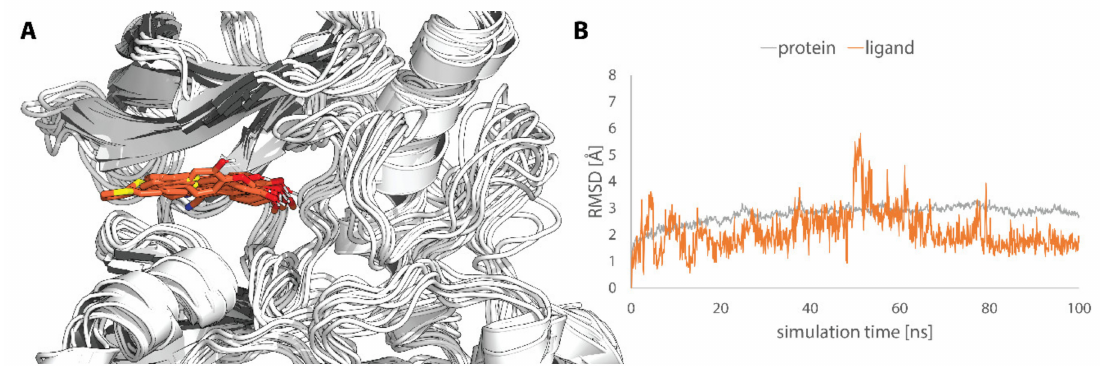
Figure 7. Results of a 100 ns MD simulation of VEGFR-2 in complex with compound 1c in the proposed binding mode. ( A ) Snapshots of the MD simulation taken every 10 ns. Compound 1c is depicted with sticks and carbon atoms colored in orange. ( B ) Root-mean-square deviation (RMSD) as a measure of the average distance between heavy atoms of ligand and protein,